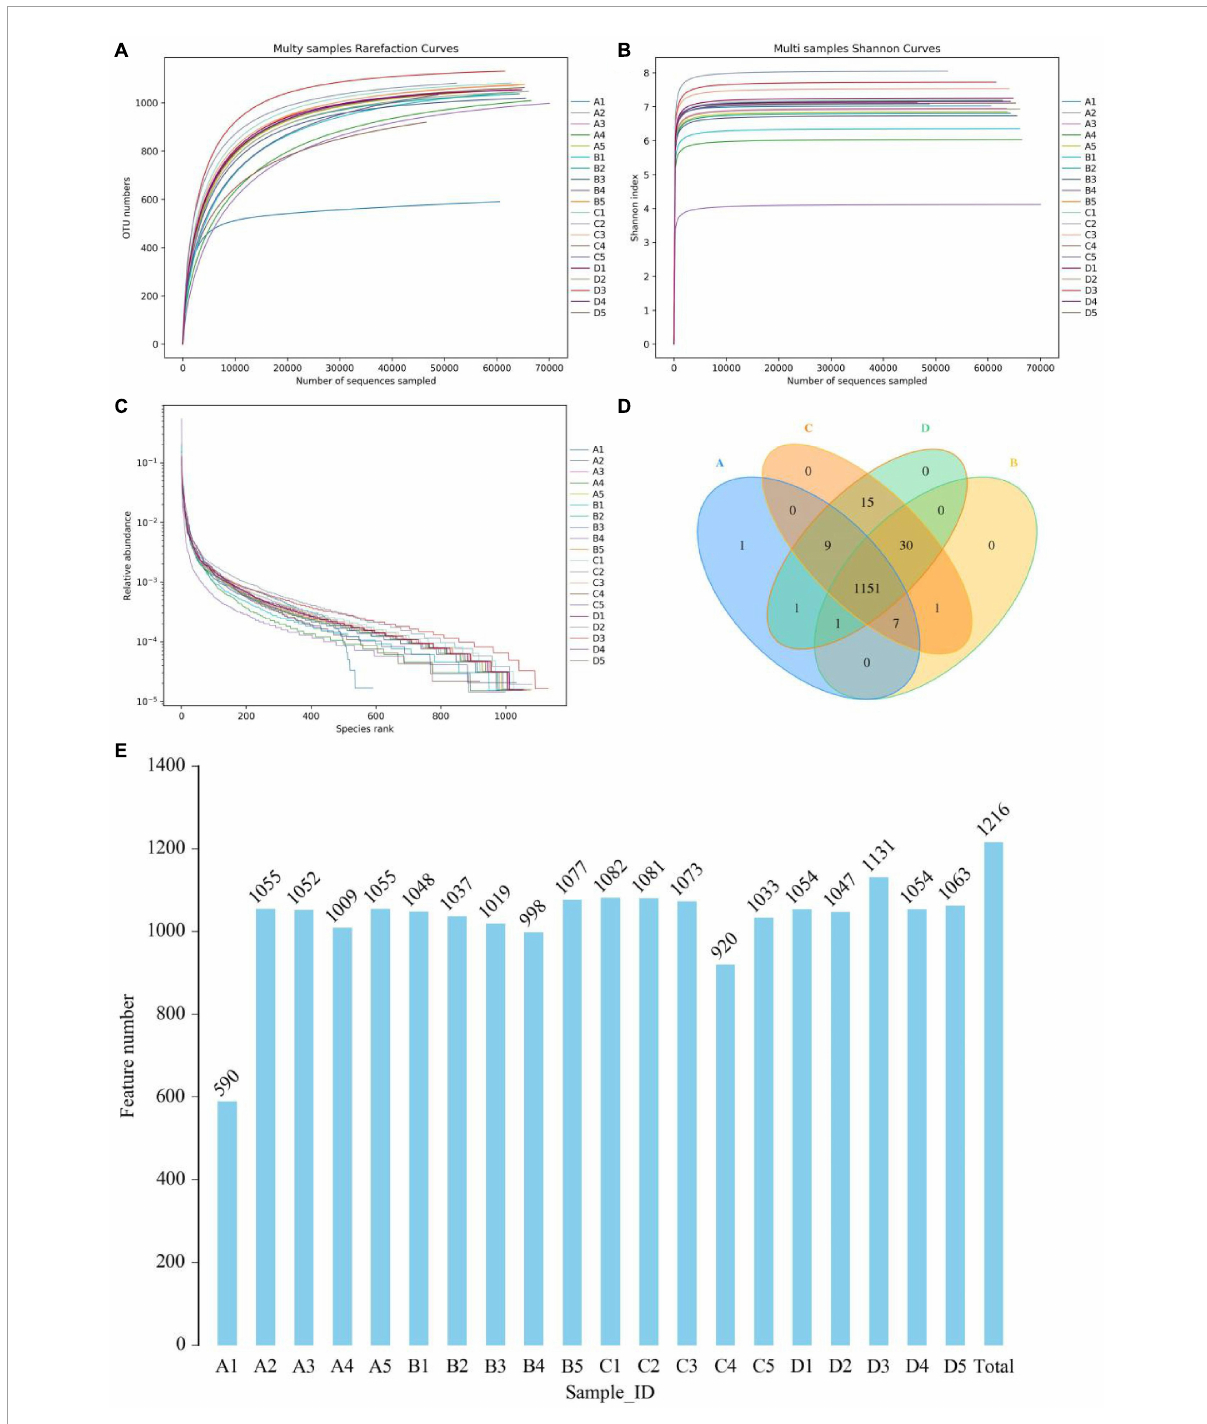
FIGURE1 Analysis of samples feasibility and OTUs composition. Sequencing depth and evenness were reflected by rank abundance (A,B) and rarefaction curves (C) . Venn diagrams for OTUs composition and distribution (D,E) .